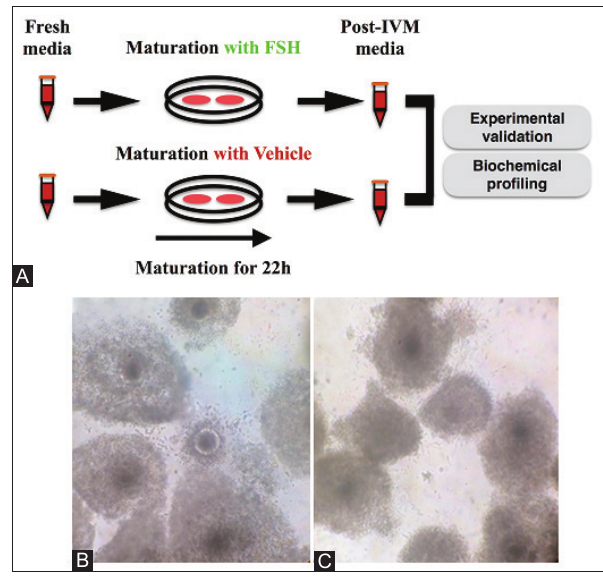
Figure-1: Experimental design and cumulus cell expansion analysis under varying follicle-stimulating hormone (FSH) conditions. (A) In vitro maturation (IVM) media collection before and after oocyte IVM for 22 h. Oocytes harvested for experimental design validation and IVM media were subject to both estradiol quantification (experimental design validation) and composition analysis (biochemical profiling). Expansion of cumulus cells of